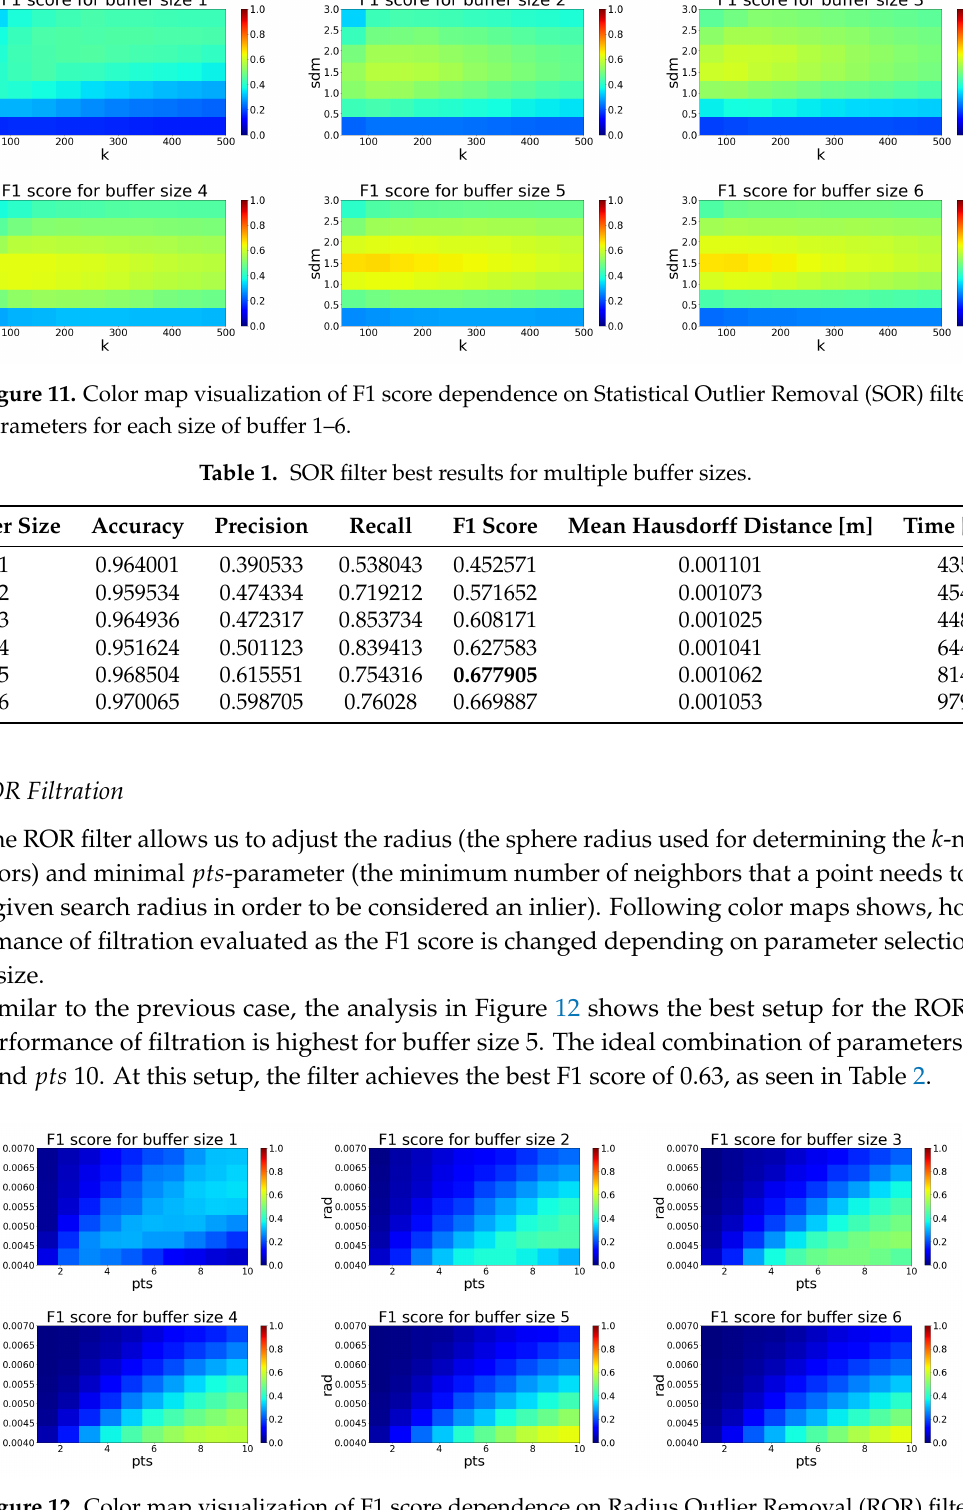
Figure 12. Color map visualization of F1 score dependence on Radius Outlier Removal (ROR) filter parameters for each size of buffer